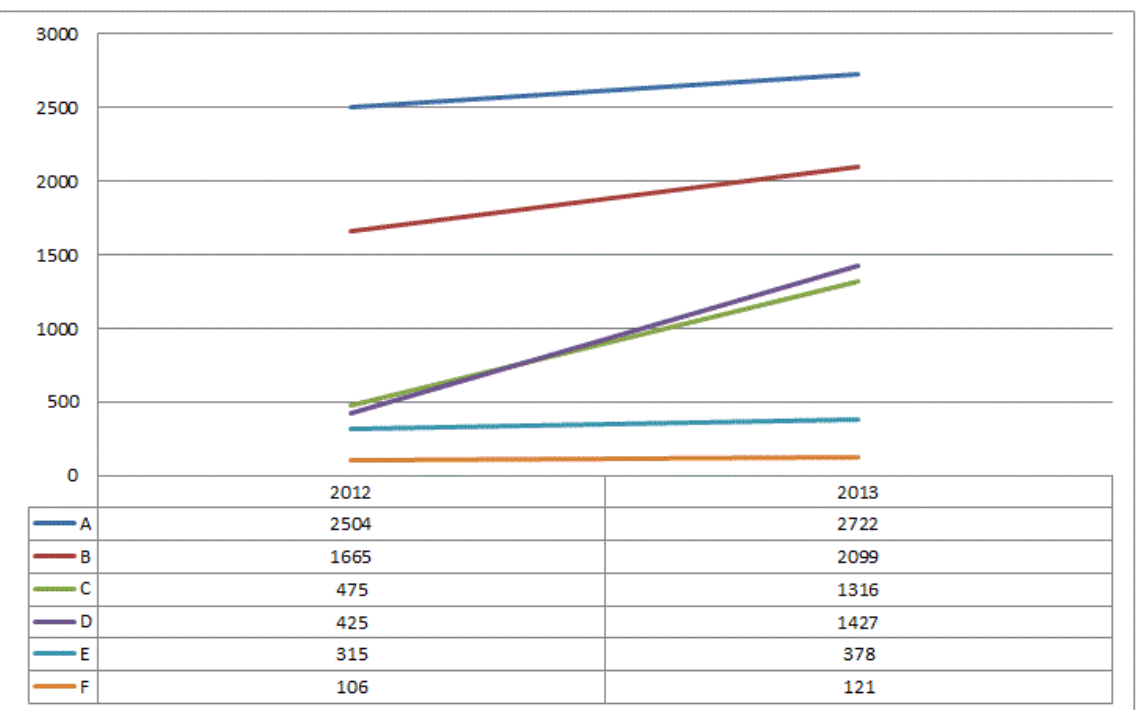
Figure 2. Number of medical appointments booked online in 2012 and 2013, by